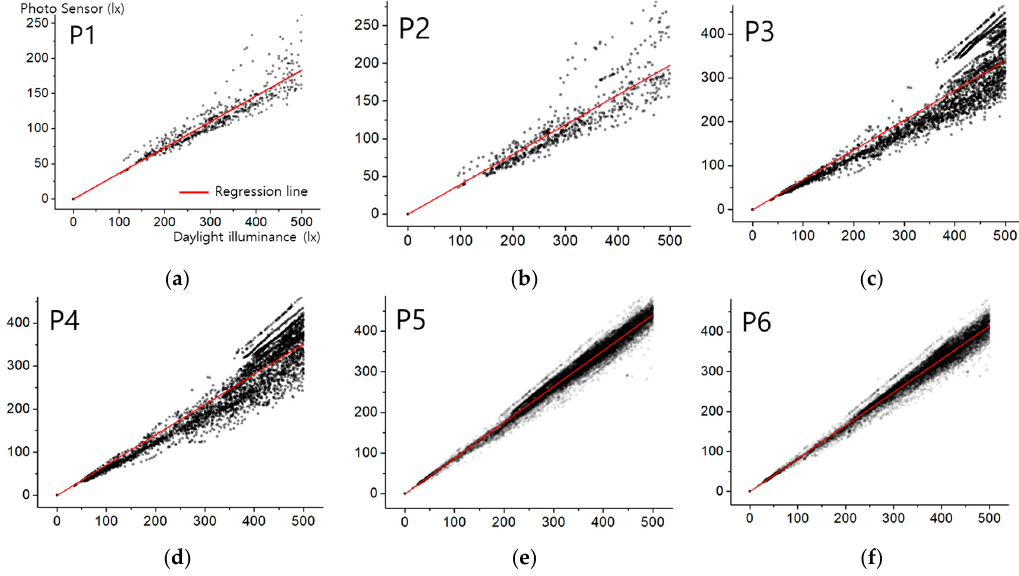
Figure 11. Results of regression analyses (photo sensor value vs. daylight illuminance) for ( a ) P1, ( b ) P2, ( c ) P3, ( d ) P4, ( e ) P5, and ( f ) P6. Table 3. Gradients of regression lines (photo sensor value vs. daylight illuminance). P1 P2 P3